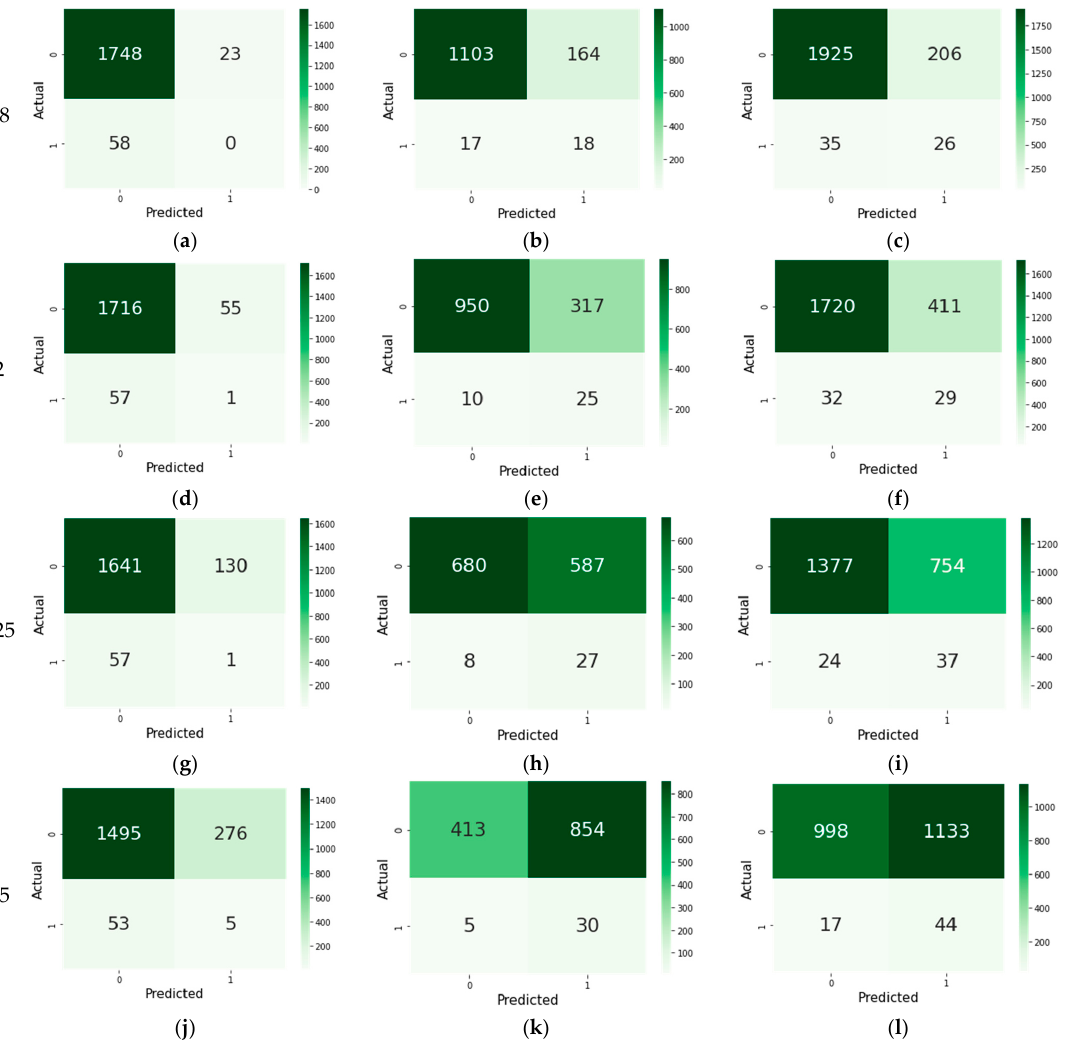
Figure 6. Confusion matrix (Eye Blink dataset). ( a ) Video 1 with 0.18 EAR threshold, ( b ) Video 2 with 0.18 EAR threshold, ( c ) Video 3 with 0.18 EAR threshold, ( d ) Video 1 with 0.2 EAR threshold, ( e ) Video 2 with 0.2 EAR threshold, ( f ) Video 3 with 0.2 EAR threshold, ( g ) Video 1 with 0.225 EAR threshold, ( h ) Video 2 with 0.225 EAR threshold, ( i ) Video 3 with 0.225 EAR threshold, ( j ) Video 1 with 0.25 EAR threshold, ( k ) Video 2 with 0.25 EAR threshold, ( l ) Video 3 with 0.25 EAR